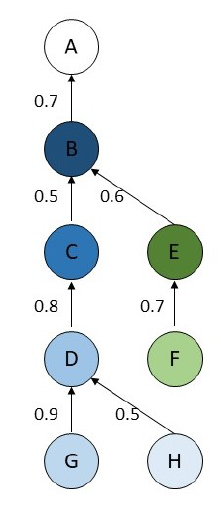
Figure 3. A routing tree with the PDR of each link used by